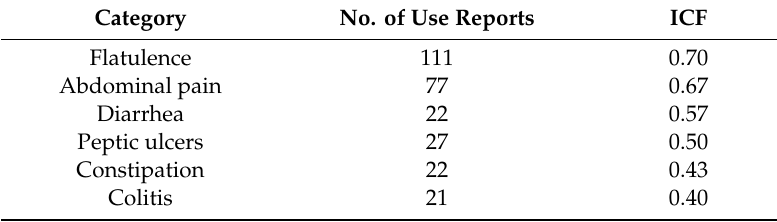
Table 2. Informant Consensus Factor (ICF) values for uses of Thai gingers for the most commonly treated symptoms related to the ICPC-2 category of digestive system